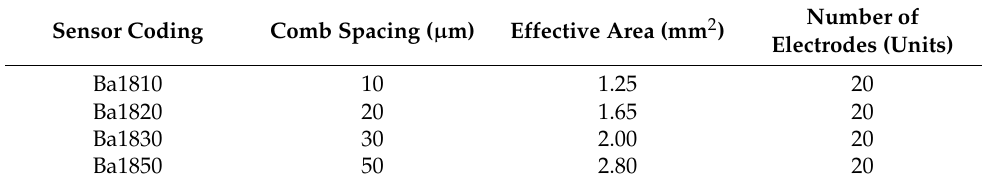
Table 1. The physical dimensions of the interdigitated electrodes.